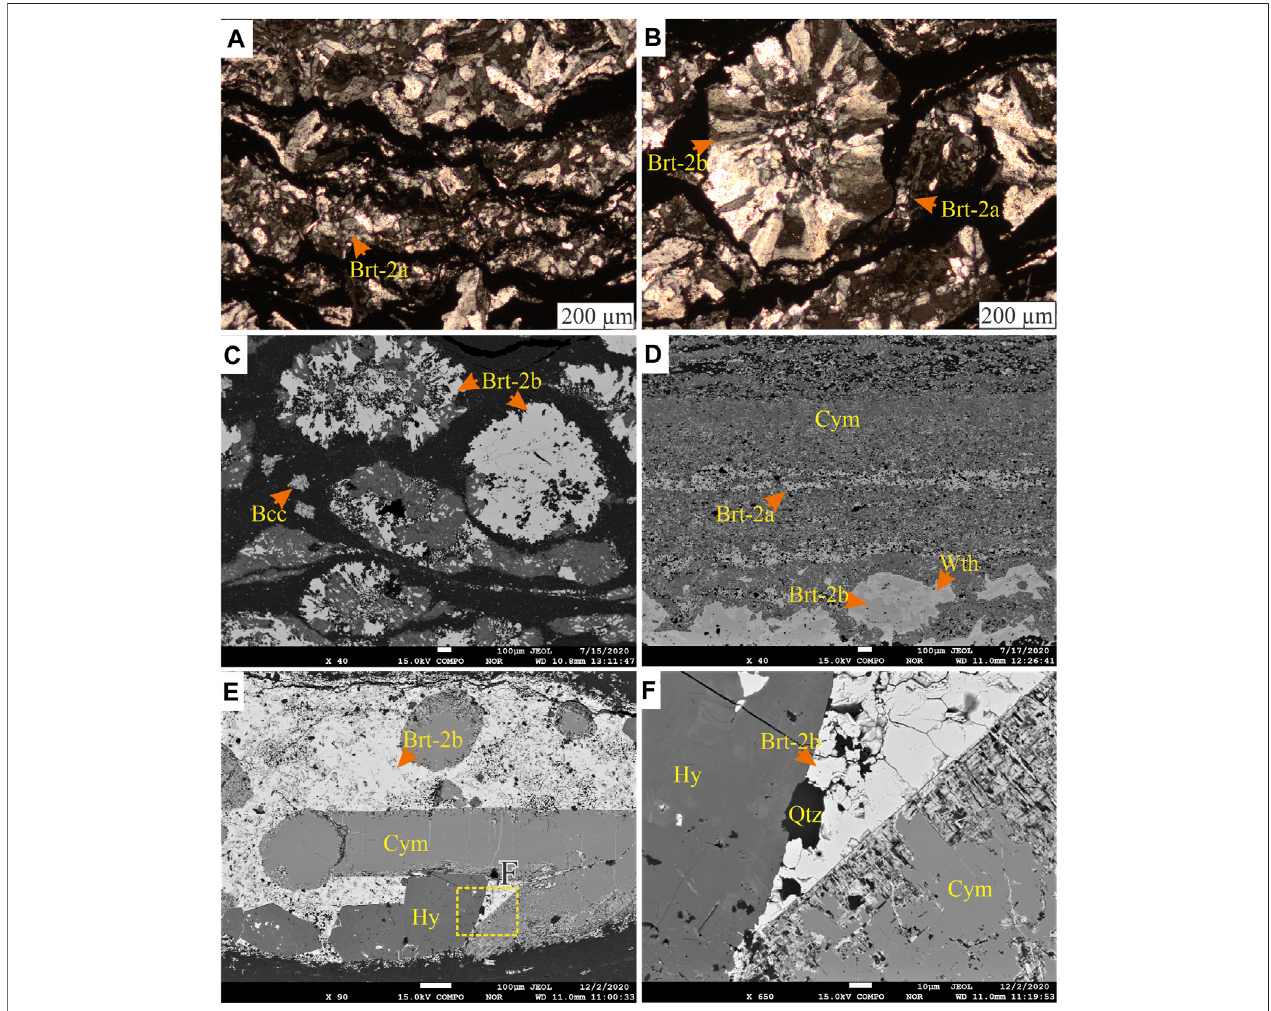
FIGURE 9 | (A) Transmitted light photomicrograph of kinked laminations of stratiform barite (Brt-2a) intercalated with clay-rich laminae. (B) Transmitted light photomicrographincross-polarizedlightoflaminatedbarite(Brt-2a)wrappingaroundnodularbarite(Brt-2b)grain. (C) BSEimageofsphericalandellipsoidalBrt-2bwith quartz intergrowth replaced by cymrite (Cym). Minor barytocalcite (Bcc) crystals are observed as spongy crystals within the matrix. (D) BSE image of laminated barite (Brt-2a) and nodular barite (Brt-2b). Brt-2b are replaced mainly by witherite, similar to the Ba-carbonate replacement of Brt-2a observable in the laminations. (E) BSE image of a nodule with subhedral to idiomorphic cymrite (Cym) and hyalophane (Hy) crystals in barite (Brt-2b). (F) BSE image of the area highlighted in image E showing the boundary relationship between the minerals present. The cymrite is seen being replaced from the margins by acicular barite and nanocrystals of quartz.